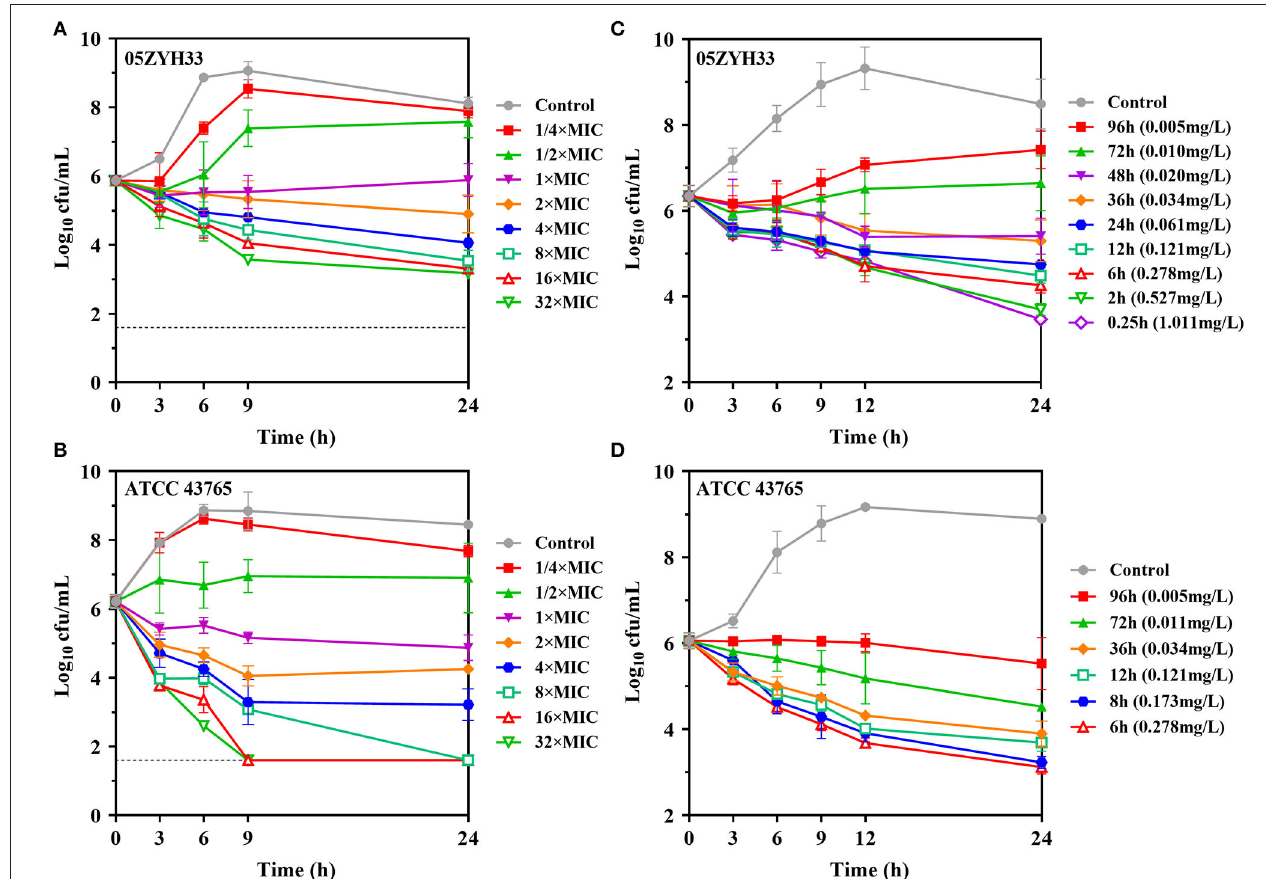
FIGURE 3 | Gamithromycin activity against S. suis . (A,B) In vitro time-kill curves of gamithromycin against S. suis 05ZYH33 and ATCC 43765 in MH broth (MIC MHB = 0.125 and 0.063 mg/L, respectively). (C,D) Ex vivo activity for S. suis 05ZYH33 and ATCC 43,765 in serum samples of piglets receiving intramuscular administration of gamithromycin at 6.0 mg/kg (MIC serum = 0.016 and 0.004 mg/L, respectively). Numerical values on the right brackets represent the mean concentrations of gamithromycin in porcine serums collected at different time points.